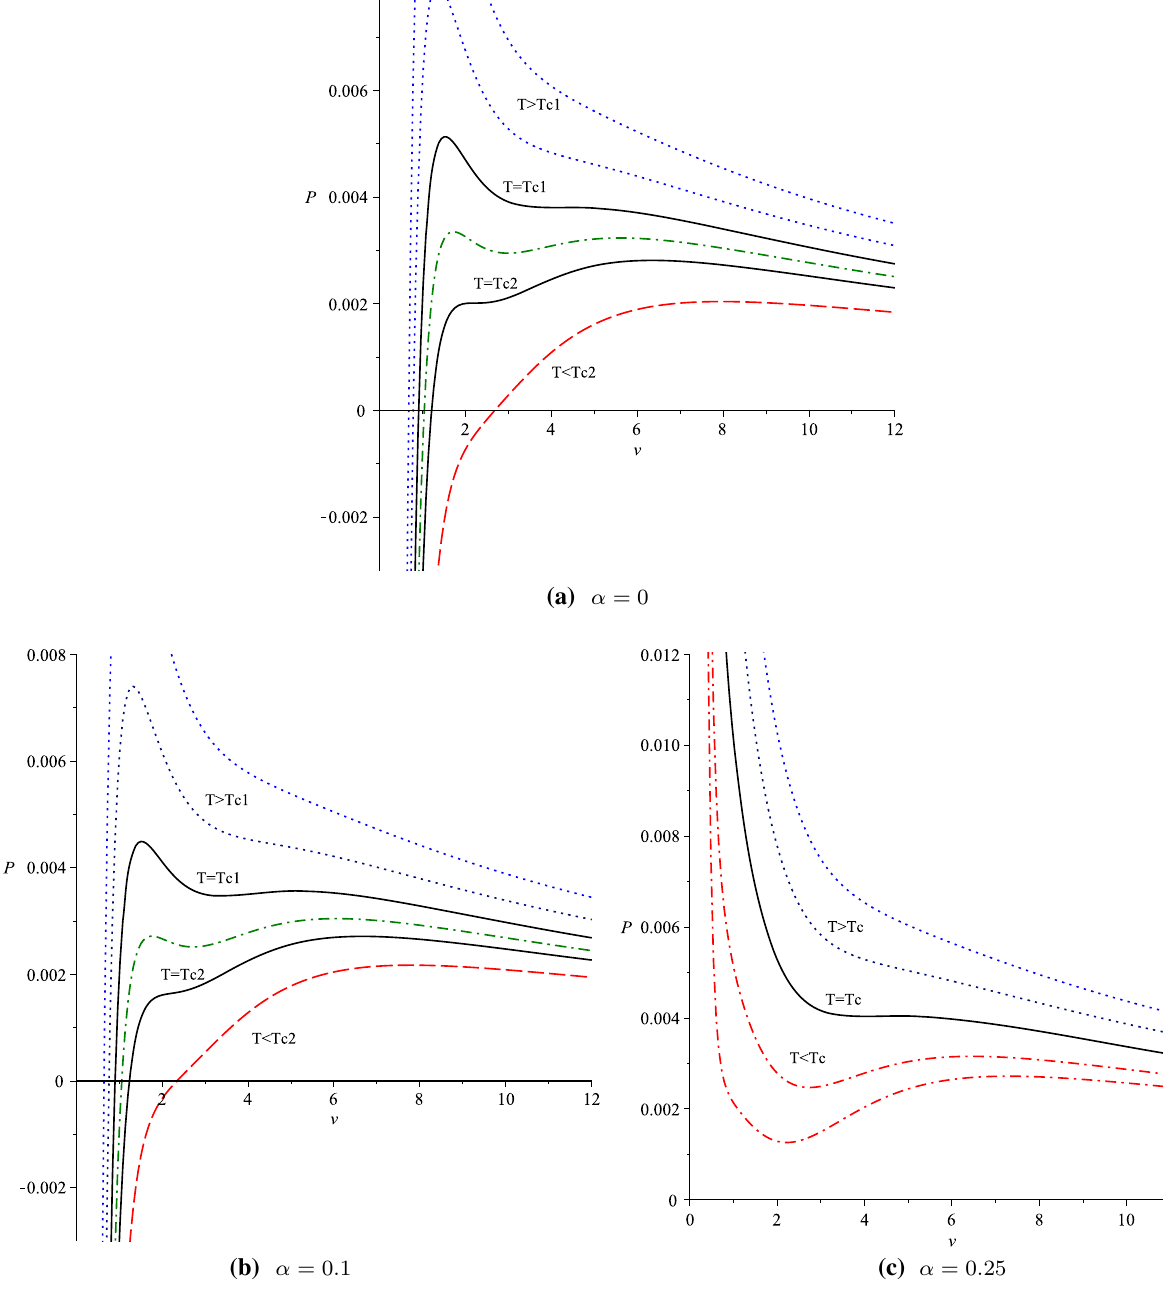
Fig. 10 P – v diagram for BID black holes. Here we have fixed β = 0 . 45, q = b = 1 and k =